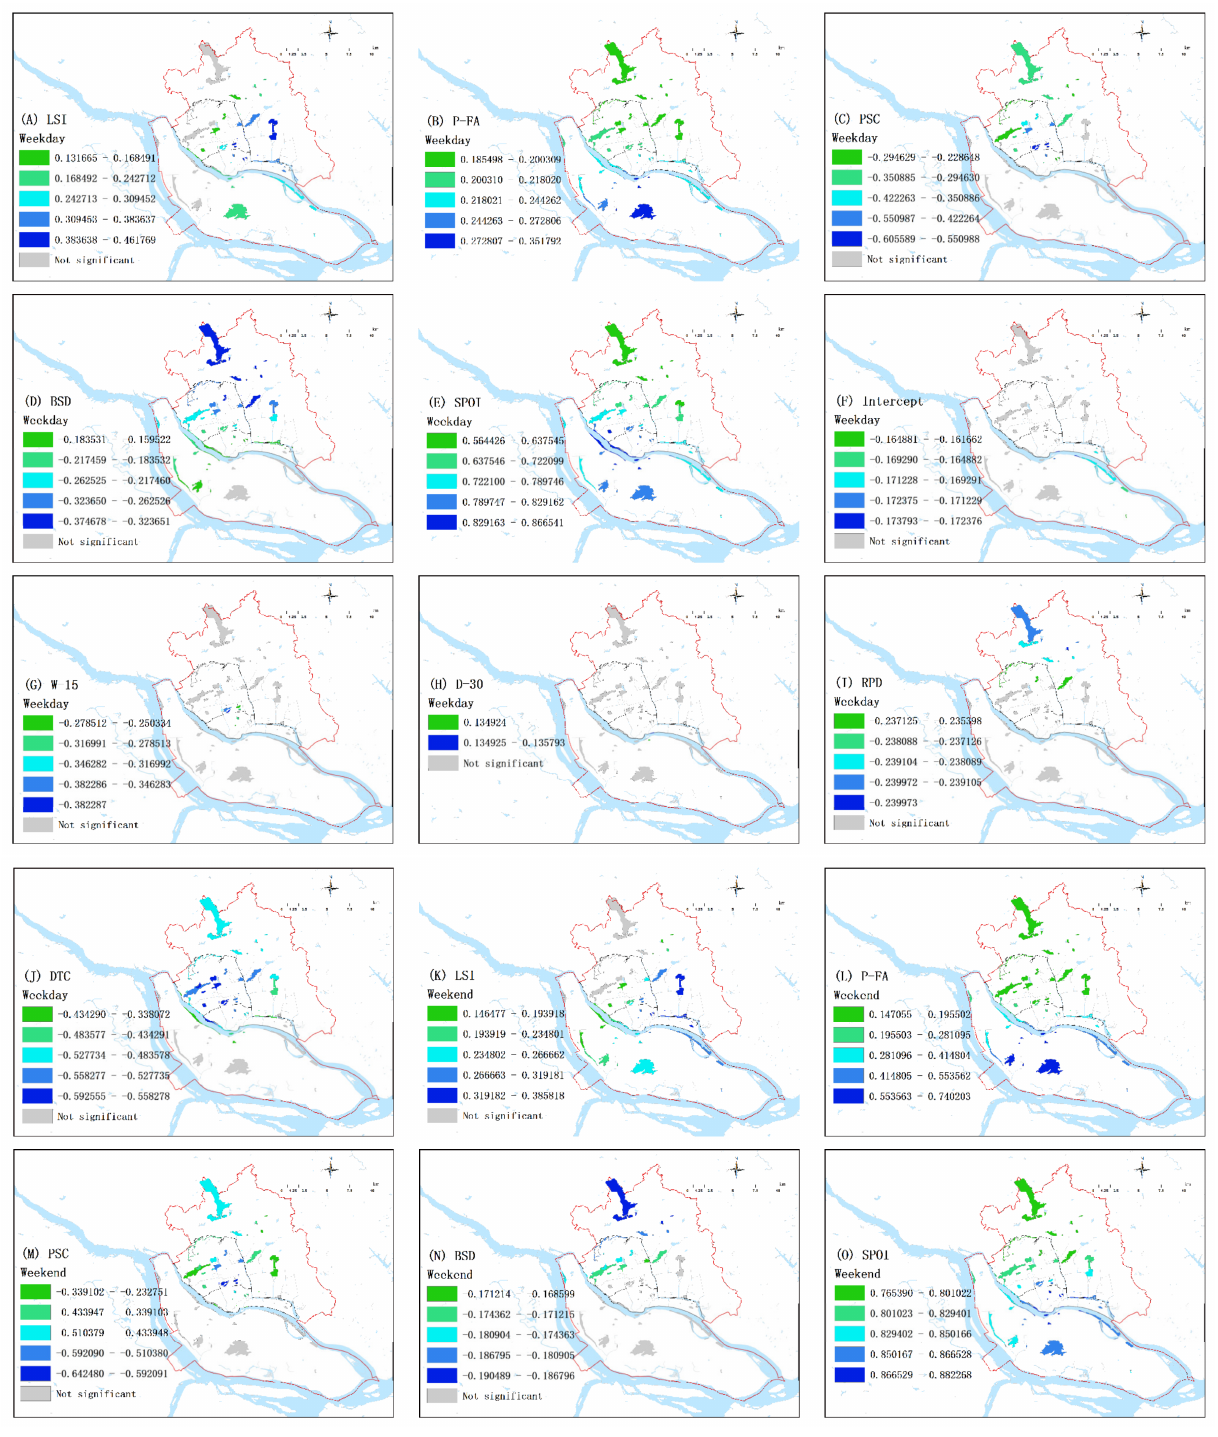
Figure 5. Spatial patterns of the regression coefficients of affecting factors in the weekday and weekend groups. Only significant variables ( p < 0.01) are